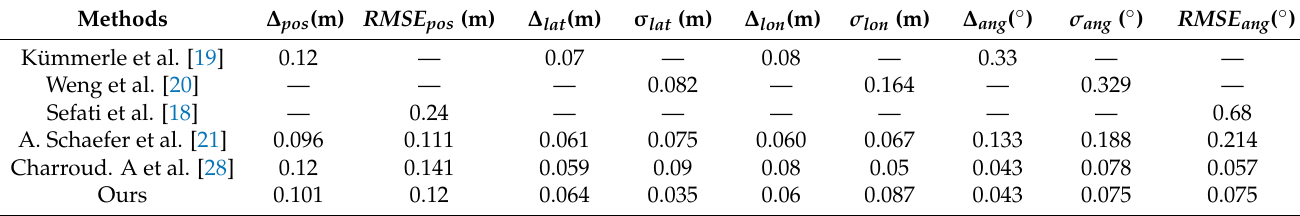
Table 3. Performance comparison of the proposed technique. The results of Weng et al. [20] and Kümmerle et al. [19] are not straightforwardly similar and are expressed for qualitative analysis